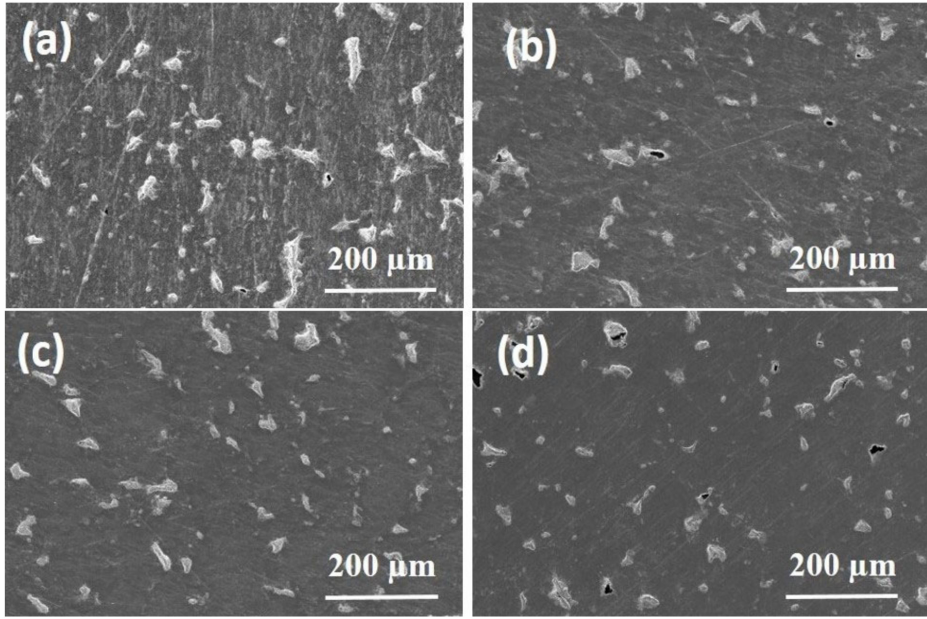
Figure 8. SEM micrographs of the deposits obtained on porous Ti substrates by the multi-step procedure: ( a ) EPD TiN-06, ( b ) EPD TiN-07, ( c ) EPD TiN-08, ( d ) EPD